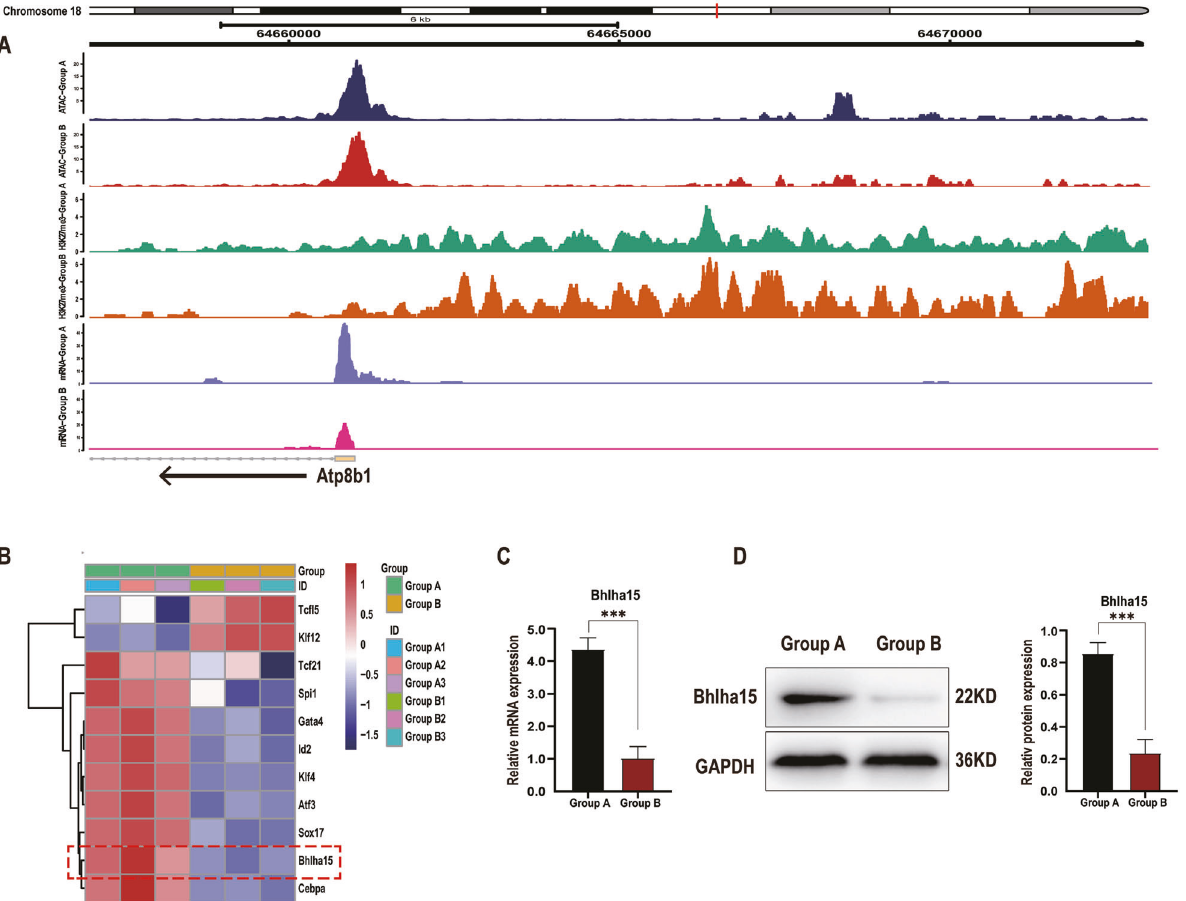
occupancy of H3K27me3 and mRNA-seq signals of genes in pancreatic acinar cells from Groups A and B w ere visualized with Integrative Genomics Viewer. B Heatmap shown 11 genes were identi fi ed by predicting the binding sites of transcription factor to the open chromatin regions around the TSS of Atp8b1 using Jaspar (threshold score, > 80). The mRNA ( C ) and protein ( D ) expression levels of Bhlha15 in pancreatic tissue were determined by quantitative RT – PCR and western blotting, respectively. *** p ≤